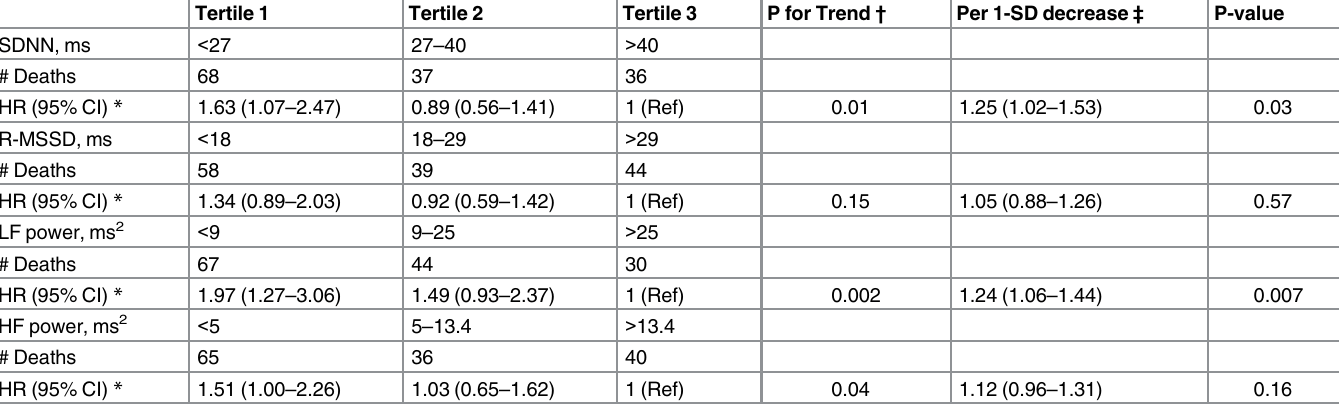
Table 3. Hazard Ratios of Sudden Cardiac Death for Heart Rate Variability Measures in Low Risk Cohort (excluding participants with CHD or Heart Failure), Atherosclerosis Risk in Communities Study, 1987 – 2001.